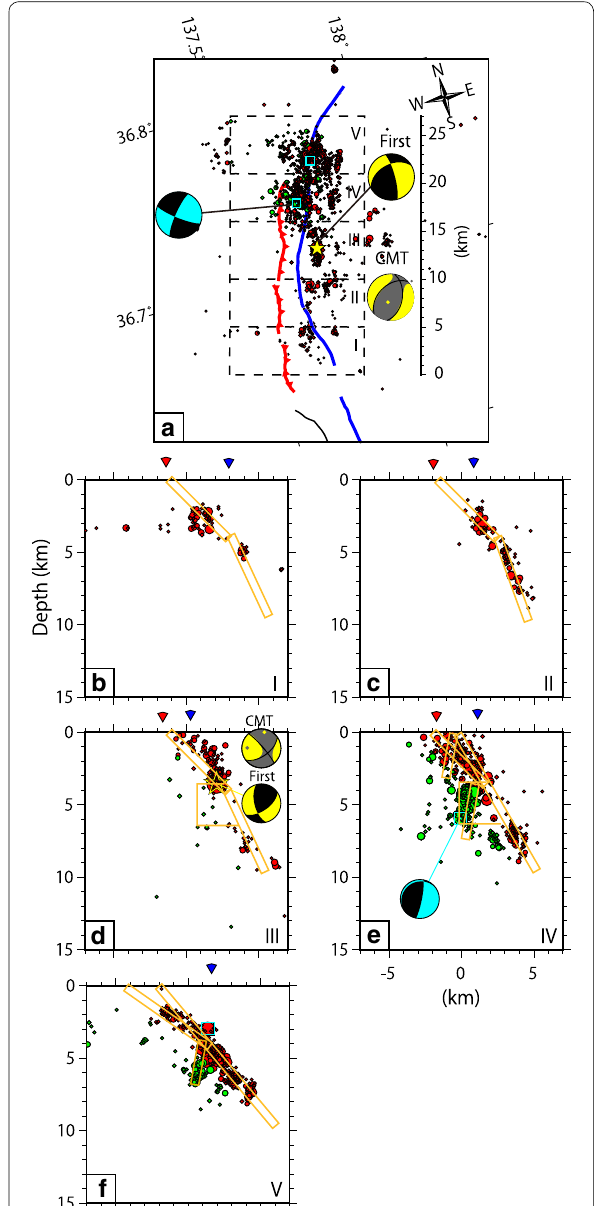
Fig. 4 Assumed fault geometry and aftershock distribution. The red and green dots, respectively, represent the hypocentral locations of the aftershocks, which are closer to the primary fault and those deviated from it, respectively (after Panayotopoulos et al. 2016). a The top view showing with the outlined fault traces (after Kato et al. 1989; Nakata and Imaizumi 2002; Kondo et al. 2008); the red and blue lines, respectively, denote surface traces of an active fault (Kamishiro fault) and a presumed geologic fault (Otari-Nakayama fault). The yellow star indicates the mainshock hypocenter. b – f The cross-sectional views for the sections I–V; the orange lines outline the cross-sectional pro- jection of the assumed fault surfaces, and the red and blue triangles correspond to the location of the two surface fault traces. The beach balls indicate the first-motion polarity and the CMT of the mainshock (yellow) and of an off-primary fault aftershock